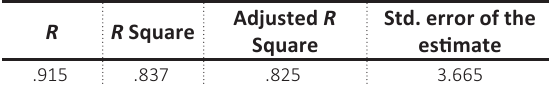
Table 5. Statistics of multiple regression of